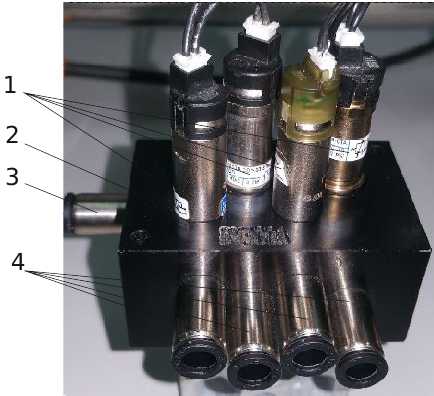
Fig. 5. General view of the valves on the panel : 1 – valves, 2 – panel, 3 – air supply, 4 – outlet way (to